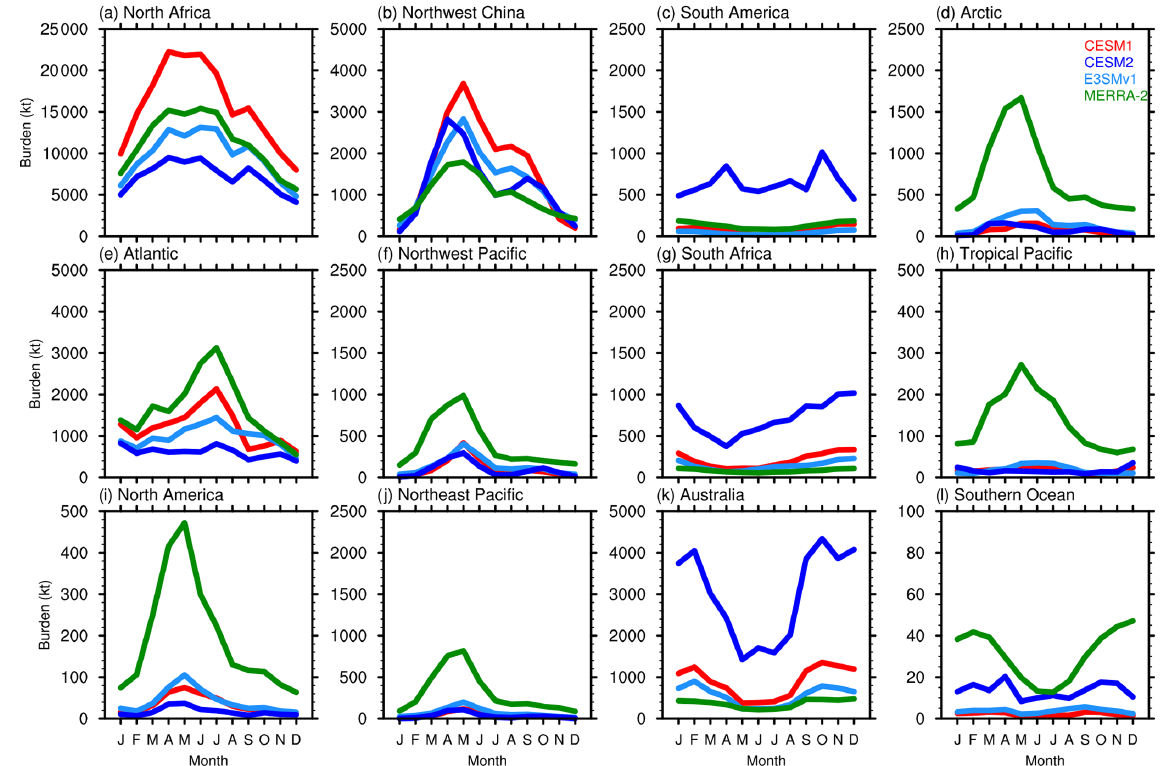
Figure 4. Seasonal variations of dust burden (kt) from model experiments over 12 selected regions during